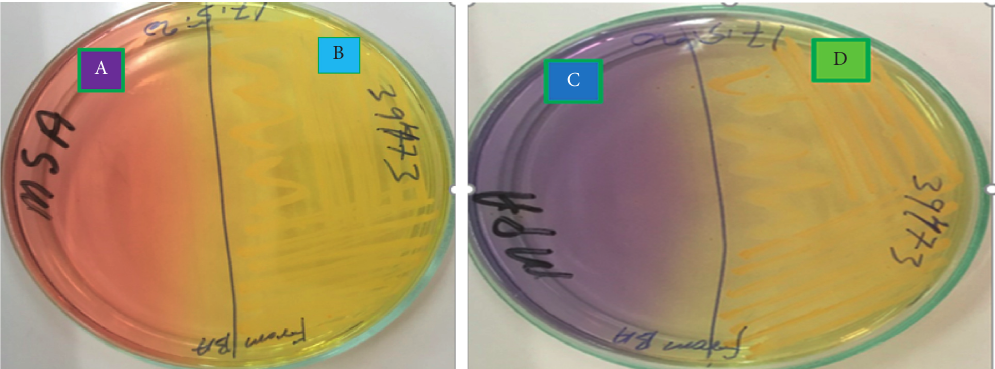
Figure 2: Golden-yellow presumptive colony of Staphylococcus aureus on mannitol salt agar (B), fermentation on 1% maltose purple agar base (D), and uninoculated agar parts (A,